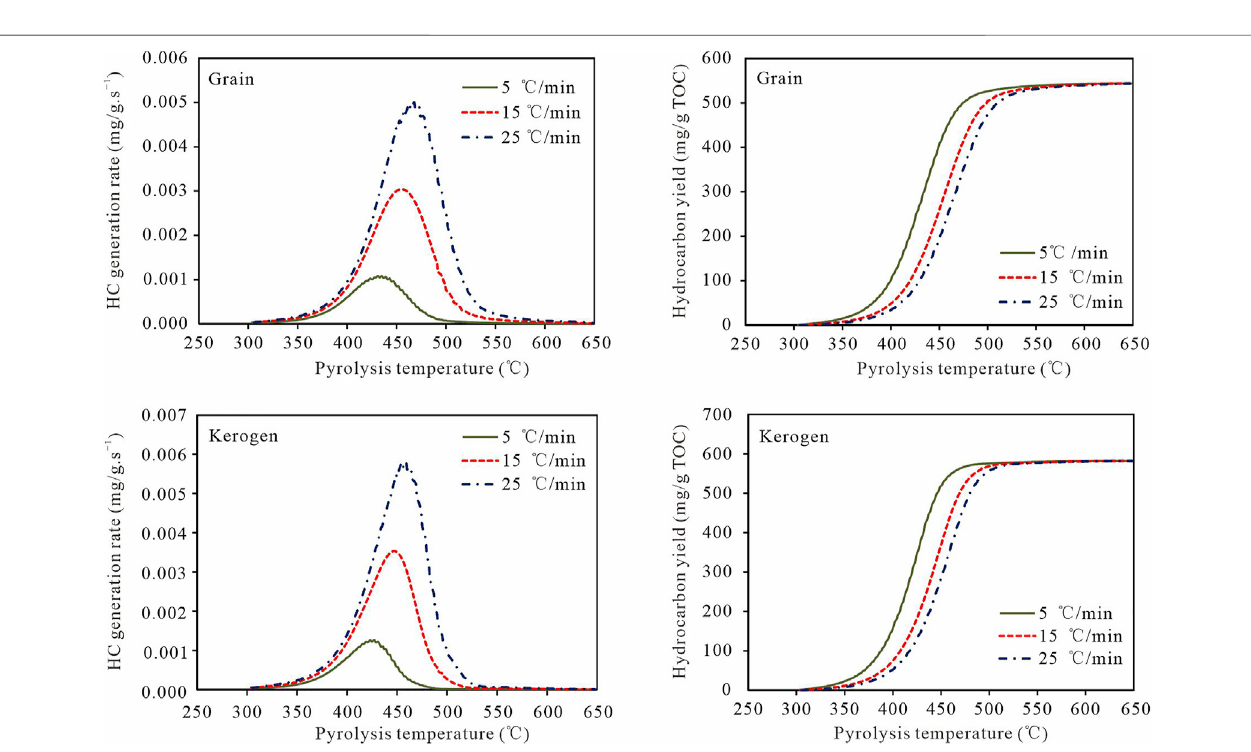
Frontiers in Earth Science |